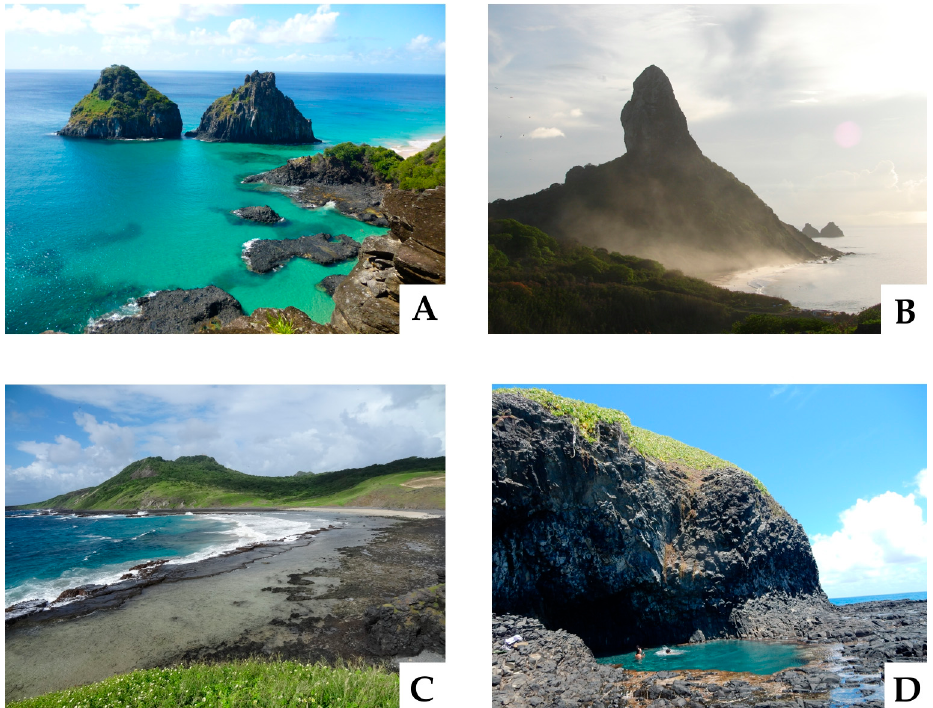
Figure 2. Four geosites of the Fernando de Noronha archipelago. ( A ) Porcos Bay, considered one of the most beautiful beaches in Brazil. ( B ) Peak Hill, the highest peak of the archipelago. ( C ) Caieira’s Cove has agglomerates, ashes, and dikes of the Remédios Formation and blocks and pebbles of the Quixaba Formation. ( D ) São José natural pool, located in São José Island. Visiting this geosite is only possible when the tide is low.